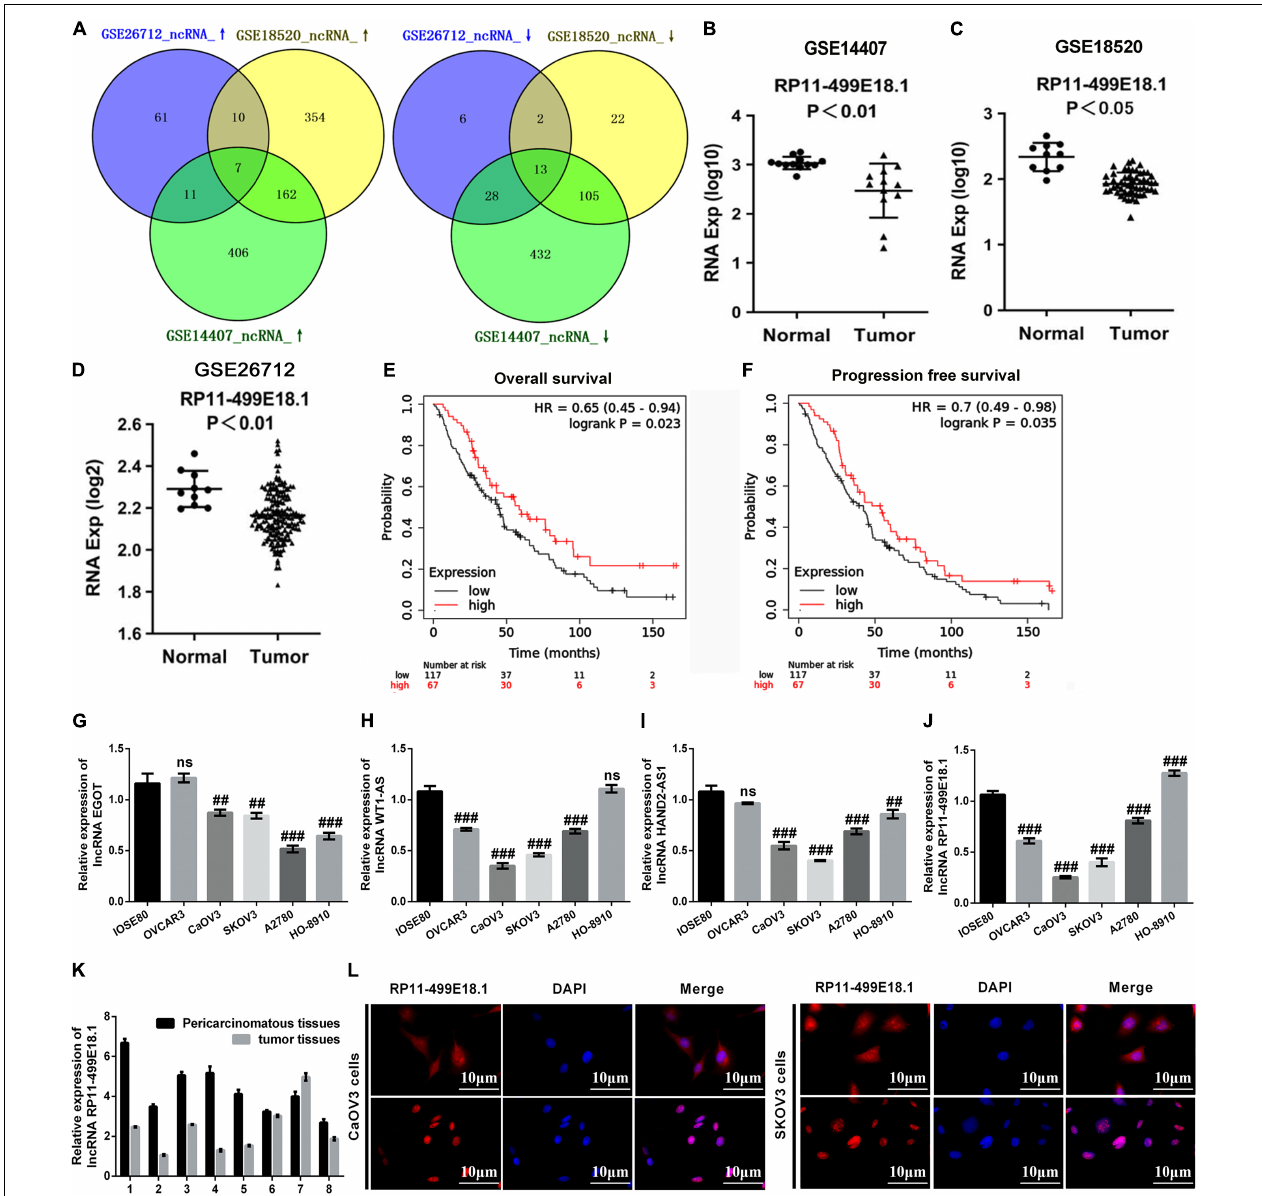
FIGURE 1 | RP11-49E18.1 was verified to be a potential tumor suppressor gene of OC. (A) Venn diagram analysis respectively identified 7 upregulated and 13 downregulated DEGs. (B–D) RP11-499E18.1 was distinctly downregulated in OC tissues. (E,F) Low expression of RP11-499E18.1 was closely associated with poor prognosis of OC patients. (G–J) RP11-499E18.1 was the lowest expressed gene in a series of OC cells, especially in CaOV3 and SKOV3 cells. (K) RP11-499E18.1 expression in OC tissues was notably lower than in pericarcinomatous tissues. (L) RP11-499E18.1 exists in cells in the form of plasma–nucleus coexistence. DEGs, differentially expressed genes; OC, ovarian cancer. ## p < 0.01, ### p < 0.001, ns, no significance.